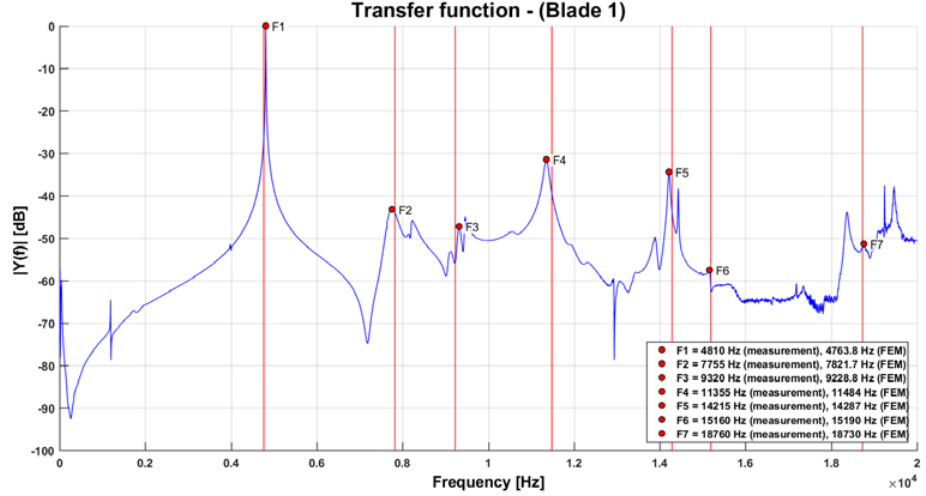
Figure 10. Transfer function and natural frequencies from FE model—with additional masses.